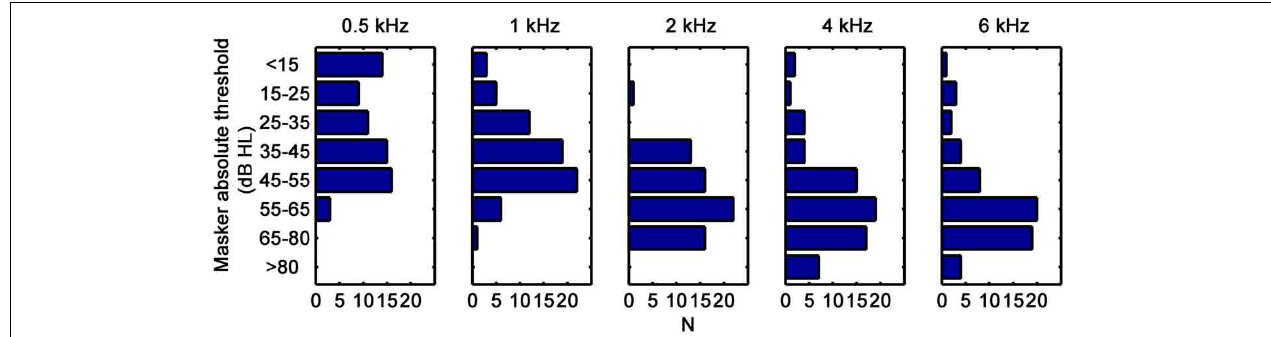
FIGURE 1 | Distributions of corrected masker absolute thresholds, in dB HL (see text for details). Each panel is for a different test frequency, as indicated at the top.